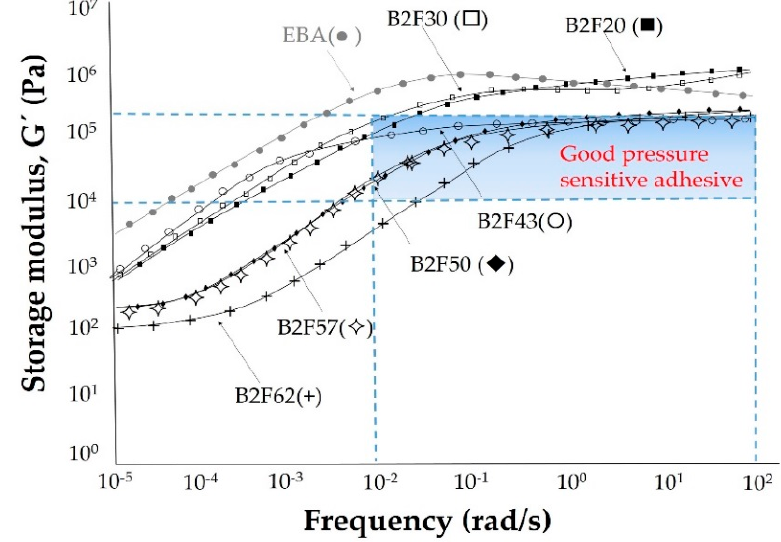
Figure 9. Variation of the storage modulus (G ′ ) as a function of the frequency for the EBA copolymer and EBA copolymer + ECH resin blends. Plate–plate rheology. Frequency sweep. T ref = 25 °C.